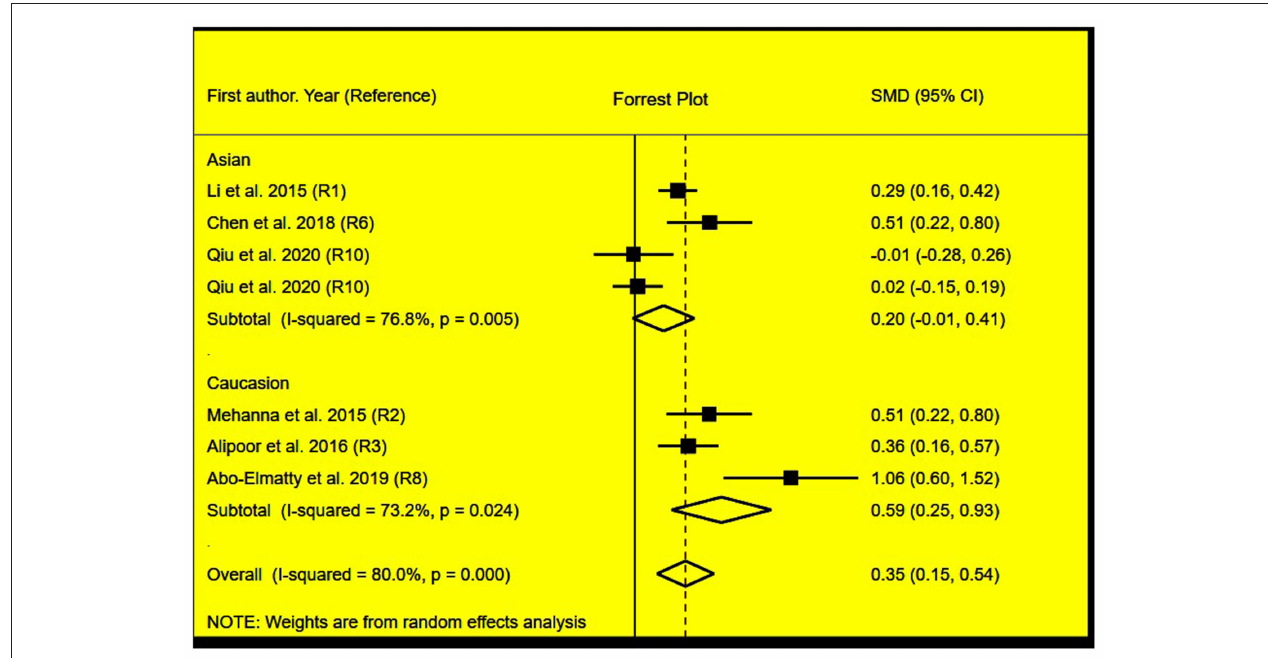
FIGURE 2 | Forest plot of the meta-analysis between miRNA-146a rs2910164 polymorphism and plasma TG levels.